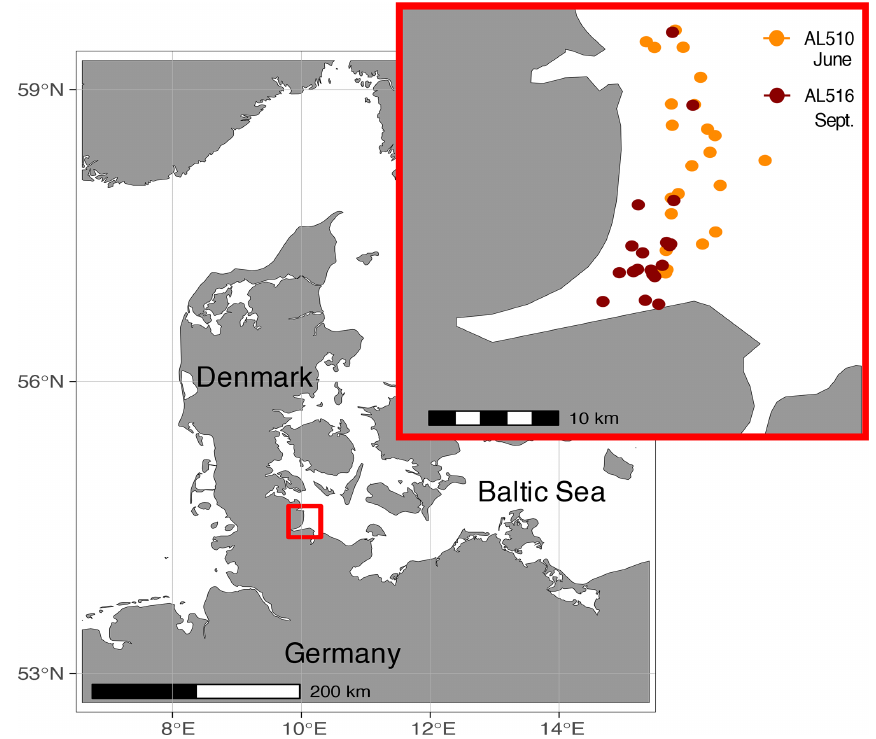
Figure 1. Samples were collected in the northern Baltic Sea at the Eckernförde Bay entrance in proximity to the coast. The first cruise was conducted in July 2018 (AL510), and orange circles indicate the 23 stations sampled during the summer cruise. The second cruise was conducted in September 2018 (AL516) during which 19 stations were sampled (red